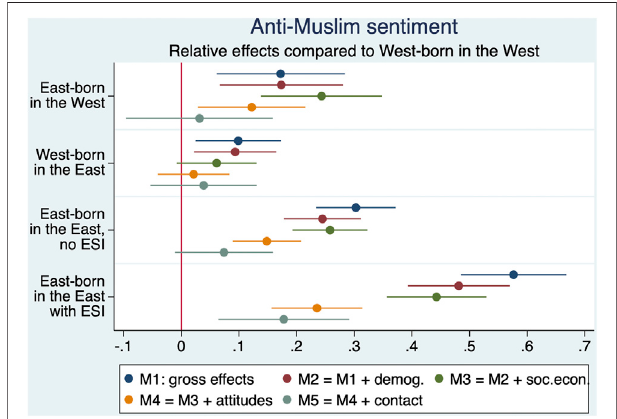
FIGURE 1 | Effects of different East-West types on anti-Muslim sentiment in several OLS